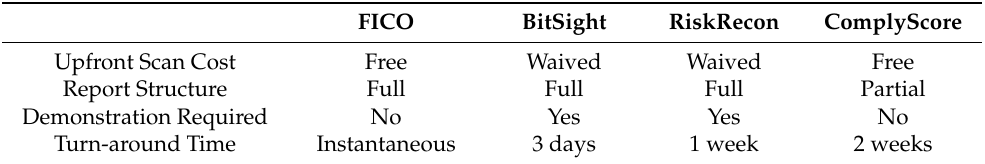
Table 1. Comparison of methodologies and reports.